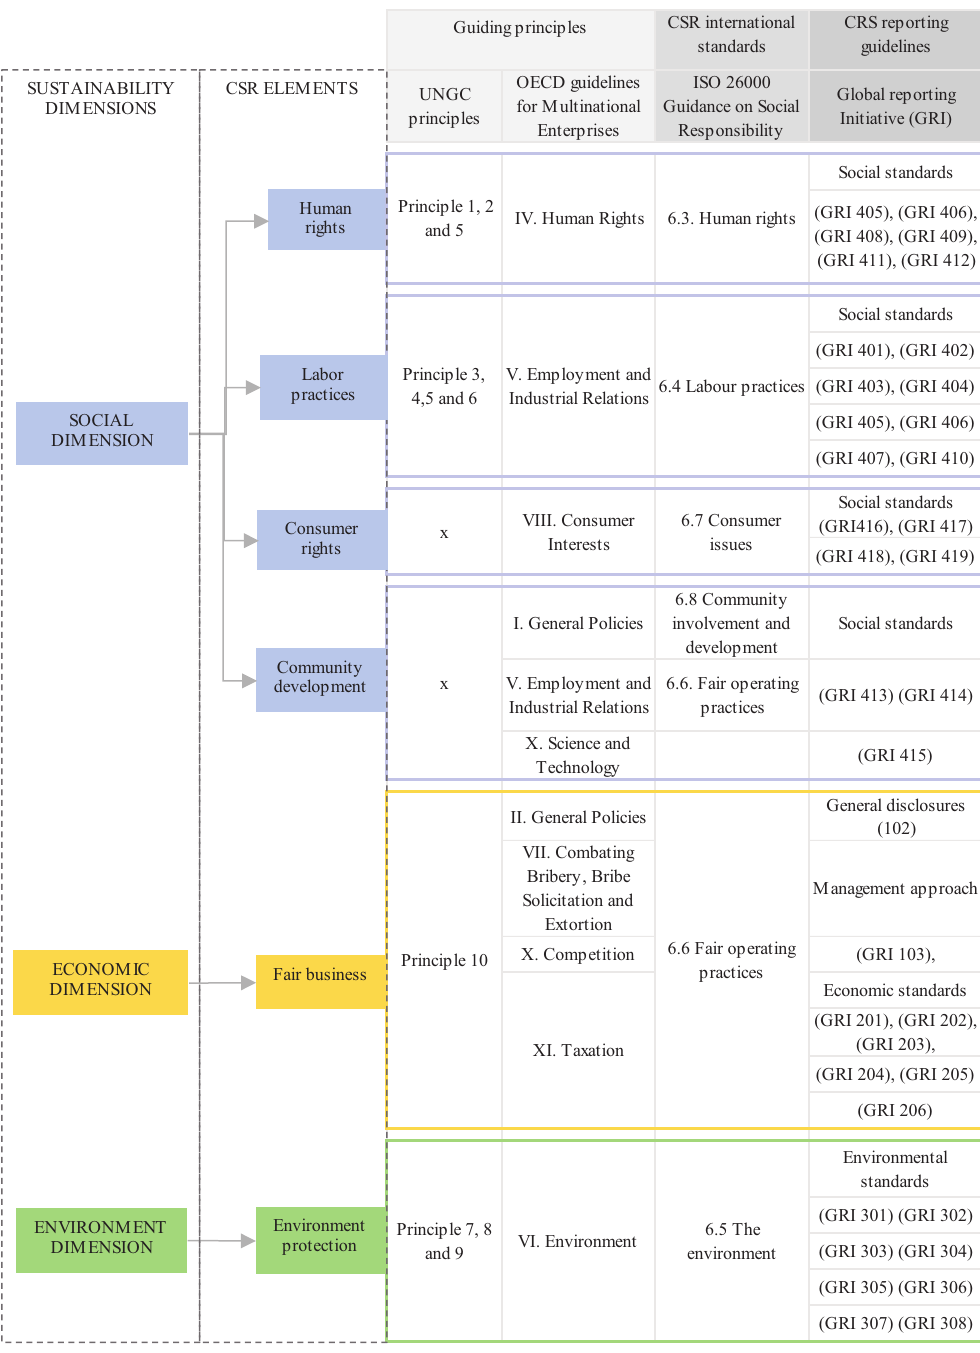
Figure 2. Link between CSR elements and topics of main instruments analysed (source: elaborated by the